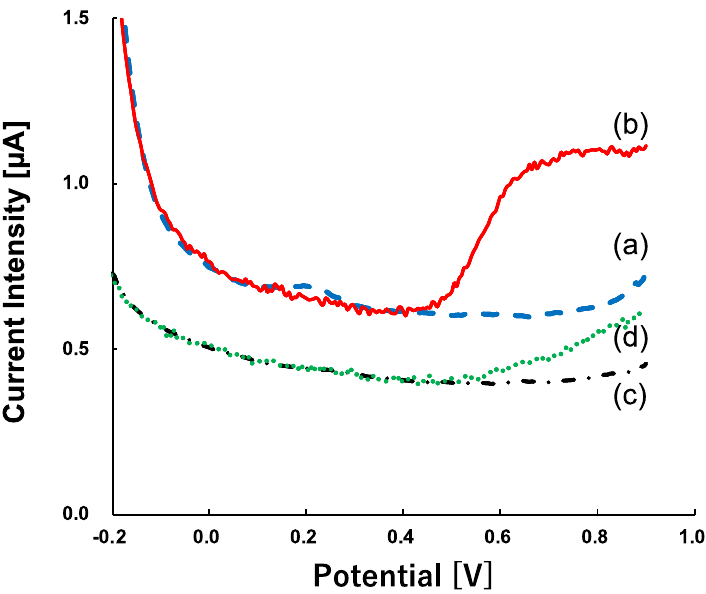
Figure 3. Differential pulse voltammogram with ACPF-containing VCM-MIP electrode in ( a ) 0 µ M and ( b ) 40 µ M VCM solution and that with unmodified ITO electrode in ( c ) 0 M and ( d ) 40 µ M VCM solution.